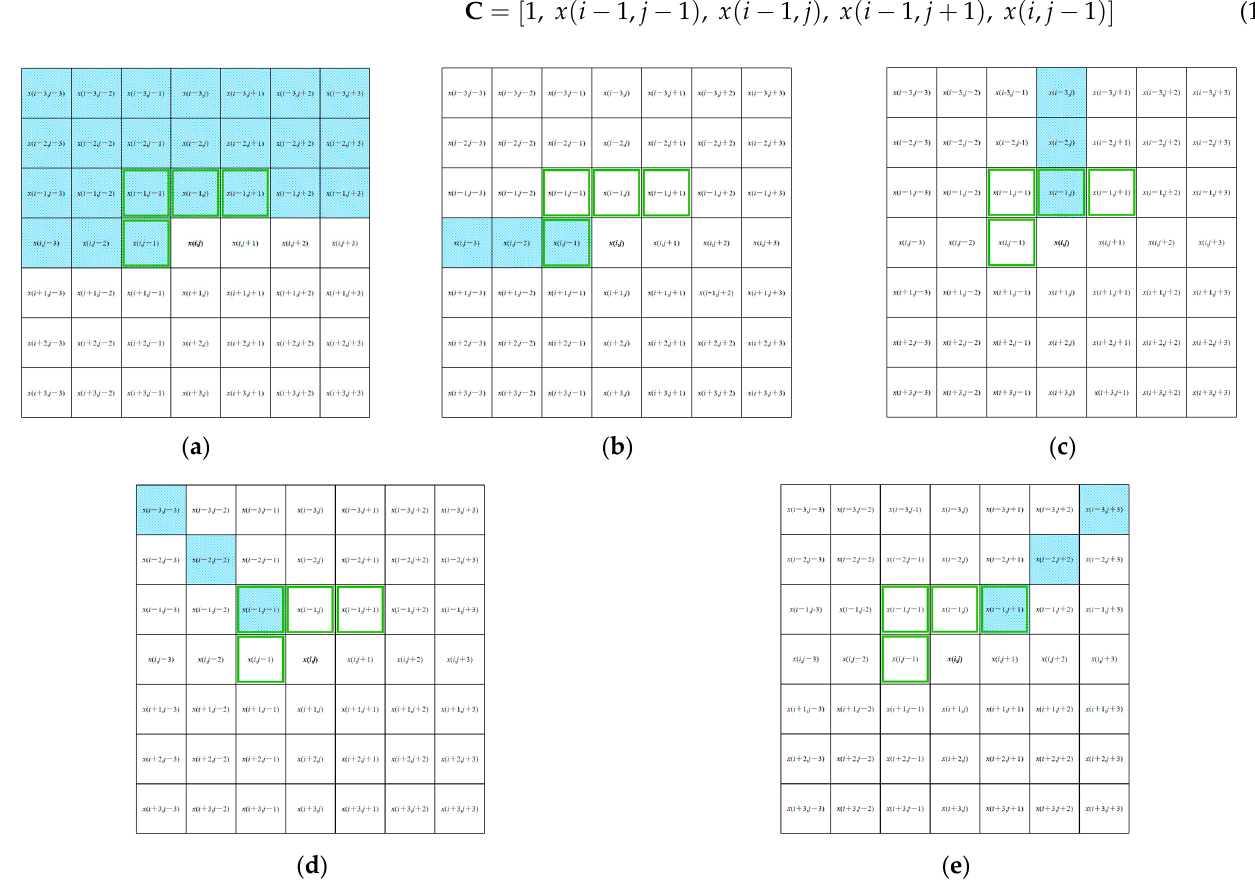
belongs to the weak edge, horizontal edge, vertical edge, positive diagonal edge, and negative di- agonal edge. The shadow pixels are the training pixels of the target pixel, and the 4 neighboring pixels in the green border are the prediction context of the target pixel.